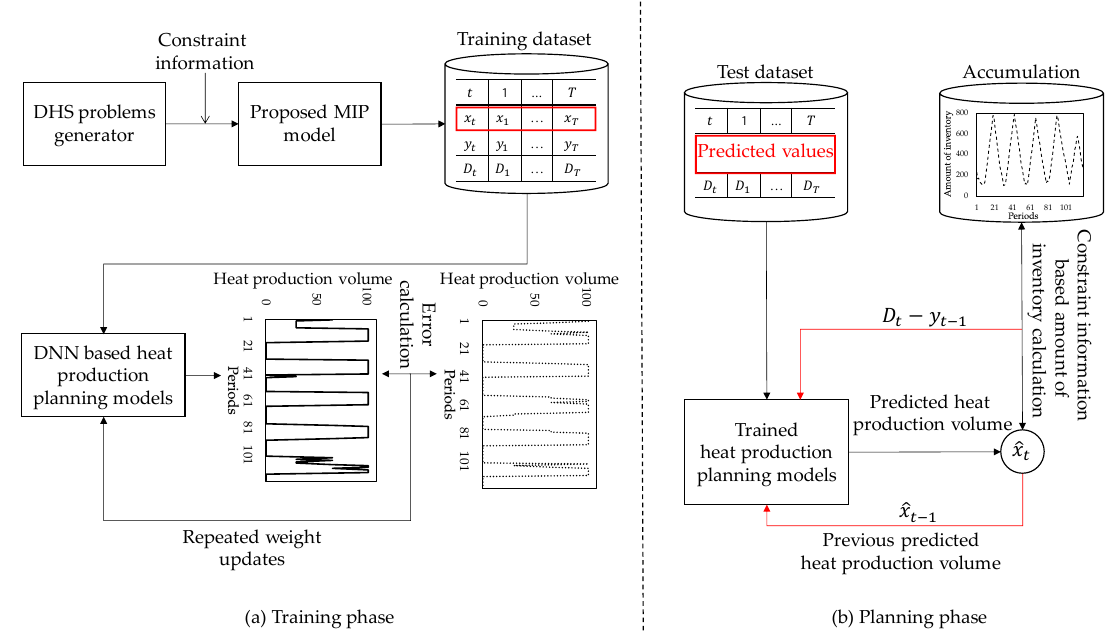
Figure 2. The proposed two-phase solution mechanism: the first training phase trains deep learning module using the optimal operation patterns from the optimization module. The second test phase generates production plans using the deep learning module trained by the optimal operation patterns.